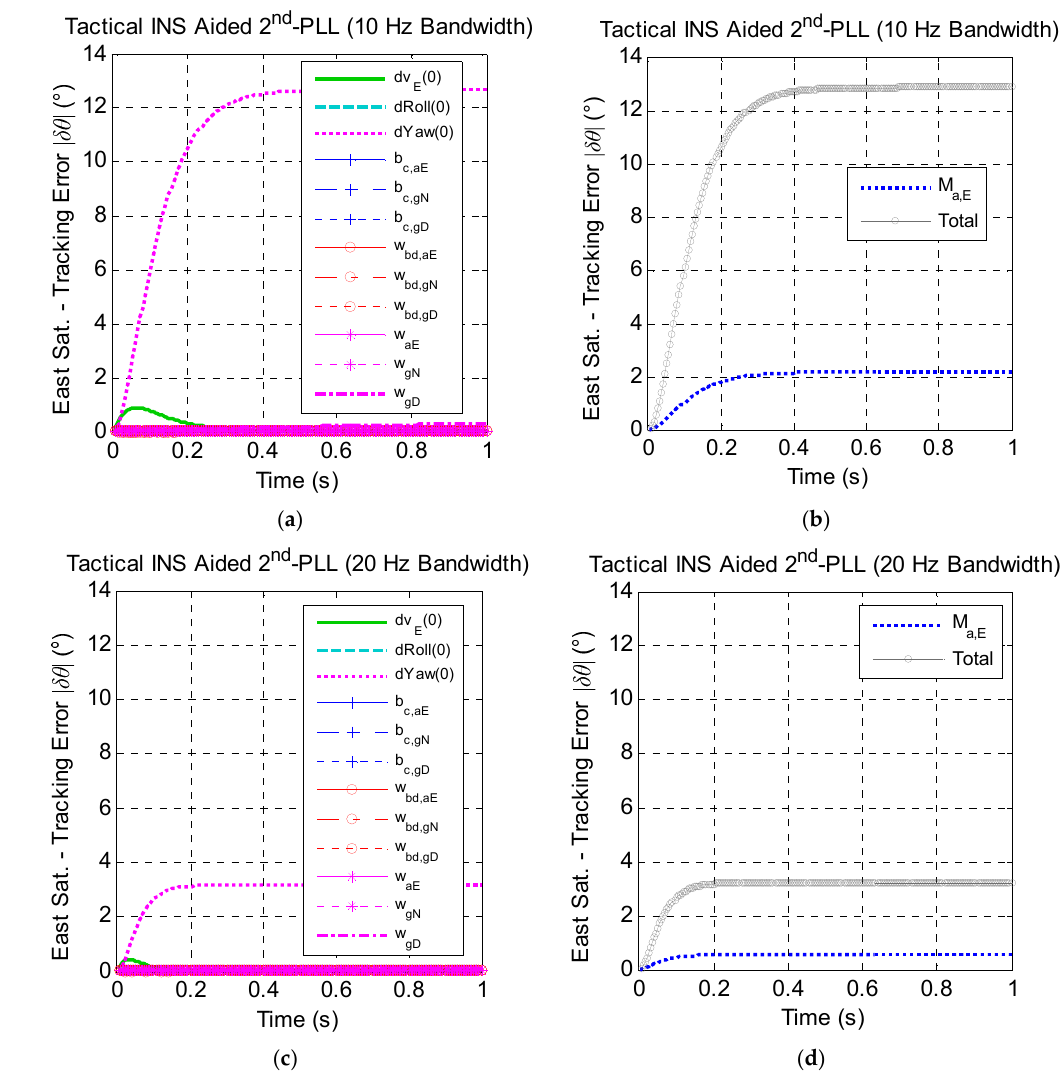
Figure 8. The east satellite tracking error caused by tactical INS error sources under the assumption of linear high dynamics along the north direction. ( a ) Effect of non-maneuver-dependent error with a 10-Hz bandwidth; ( b ) effect of maneuver-dependent error with a 10-Hz bandwidth; ( c ) effect of non-maneuver-dependent error with a 20-Hz bandwidth; ( d ) effect of maneuver-dependent error with a 20-Hz bandwidth. (* Here, Sat. is the abbreviation of satellite.)